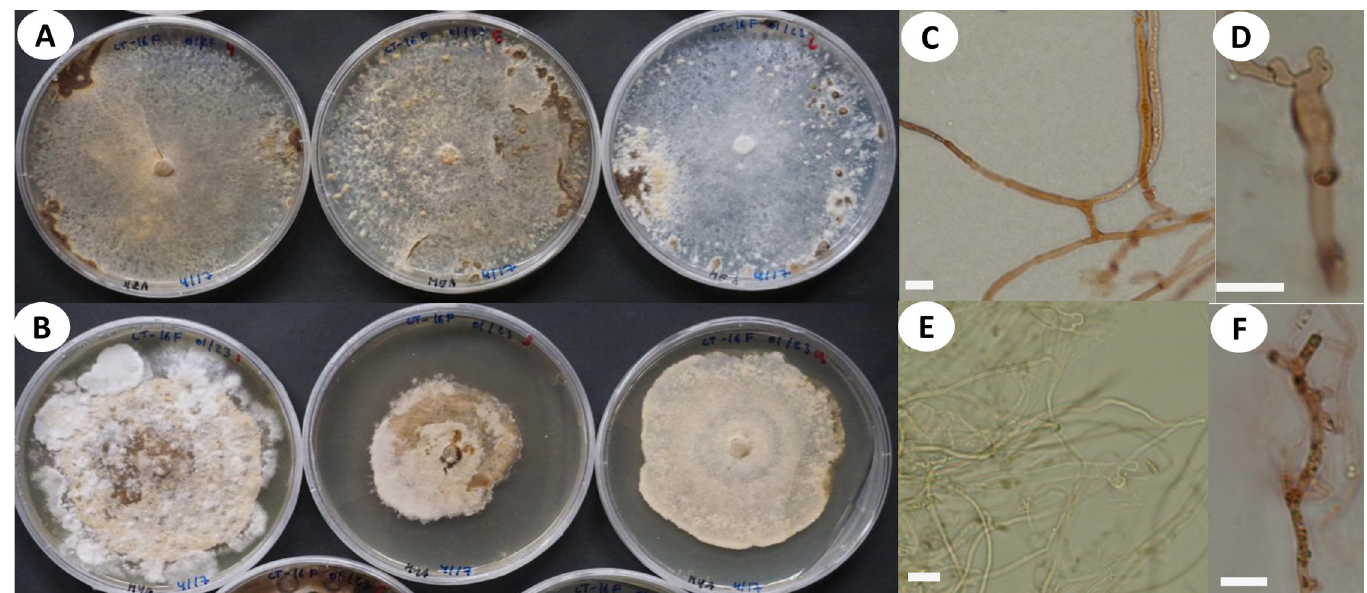
Fig 14. Cultural characteristics and microscopical features of P . leprieurii var. yasuniensis . A. Macromorphology of colonies on MEA. B. Macromorphology of colonies on MYA. C. Slightly branched section of hyphae from white mycelium (Red Congo). D. Generative hyphae with clamp connection (Red Congo). E. Thin-walled hyphae from white sections of mycelium (Melzer’s reagent). F. Highly nucleated section of hyphae (Red Congo). Scales bars = 10 μ